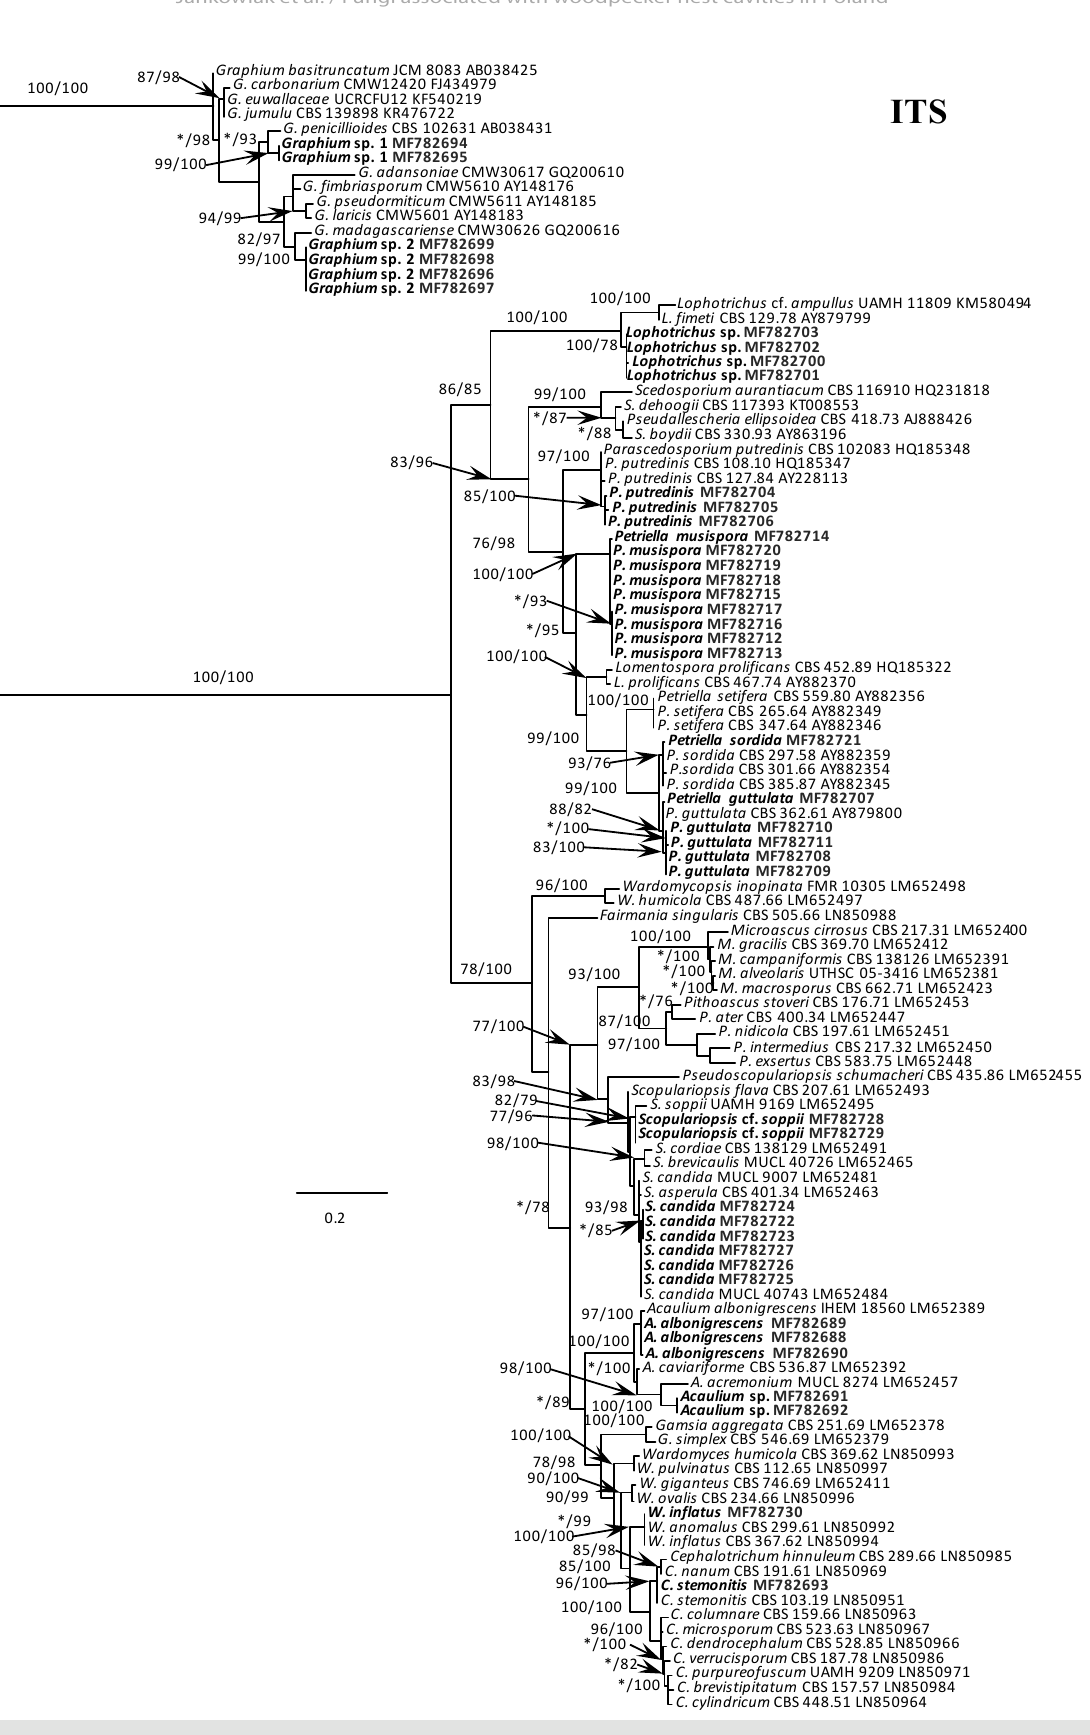
Fig. 1 Phylogram obtained from maximum likelihood (ML) analysis of the internal transcribed spacer (ITS) region. The phylogram shows the placement of isolates obtained from woodpecker nest cavities representing the order Microascales. Sequences obtained during this study are presented in boldface. Bootstrap values >75% for ML and posterior probabilities >75% obtained from Bayesian (BI) analysis are presented at nodes as follows: ML/BI. * Bootstrap values